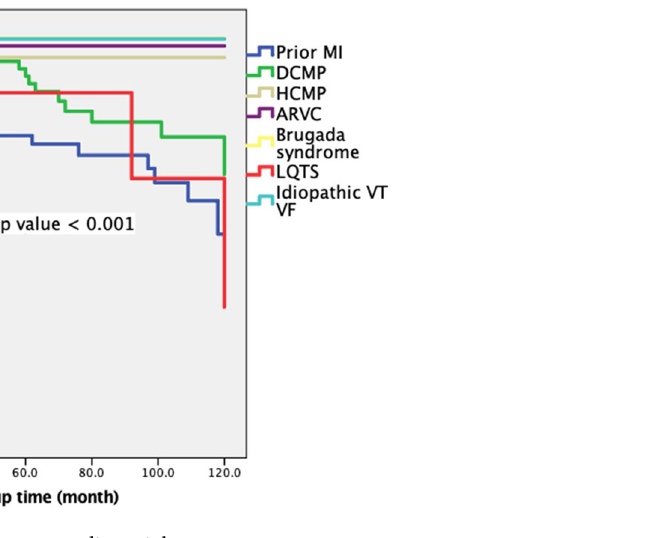
Figure 2. Kaplan–Meier curve according